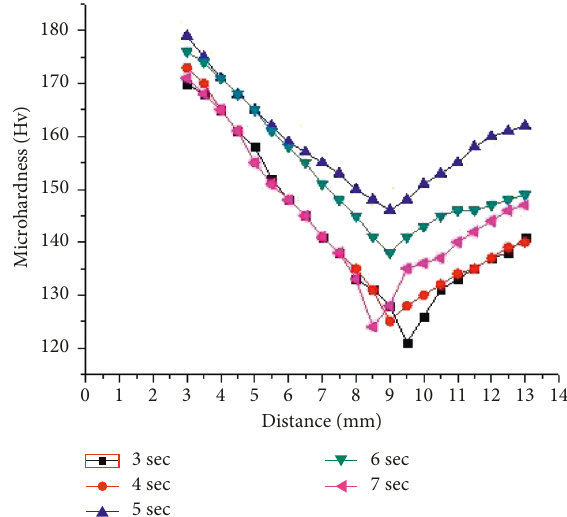
Figure 2: Microhardness distribution of FSSW